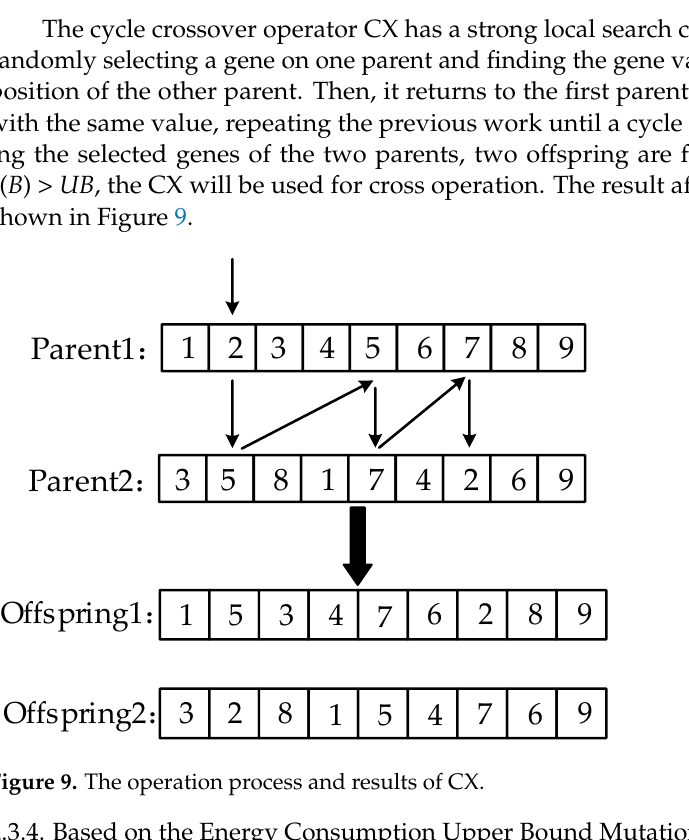
Figure 8. Results for order crossing operators.